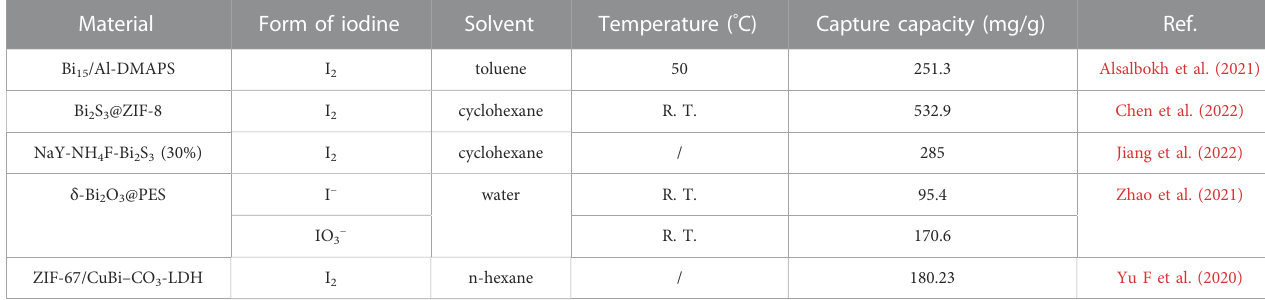
TABLE 3 Recent Bi-based materials for iodine capture in